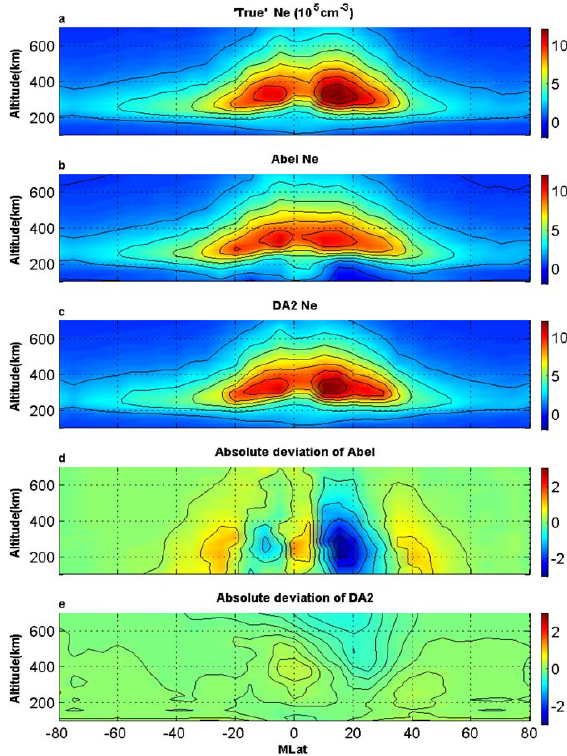
Fig. 38. Altitude-latitude cross sections of electron density (Ne in 10 5 cm − 3 ) at midday (Local time LT=13). The top panel is the as- sumed “true” Ne cross section. The second and third panels from the top are the cross sections obtained from the Abel and data as- similation retrievals, respectively. The 4th and 5th panels from the top show cross sections of the errors associated with the Abel and data assimilation retrievals, respectively (Yue et al., 2011).